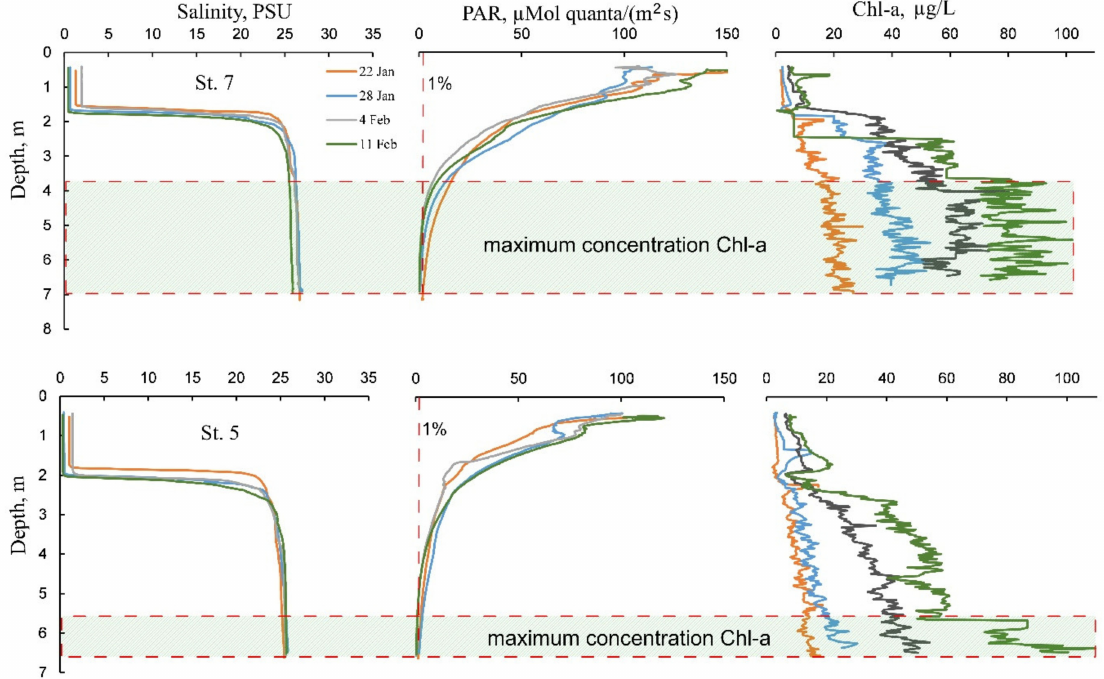
Figure 10. Vertical distribution of salinity, PAR, and Chl-a at St. 7 ( top panel ) and St. 5 ( bottom panel ) (note: survey 5 is not shown). The red vertical dashed line indicates the threshold (1% of the PAR intensity) relative to the surface water